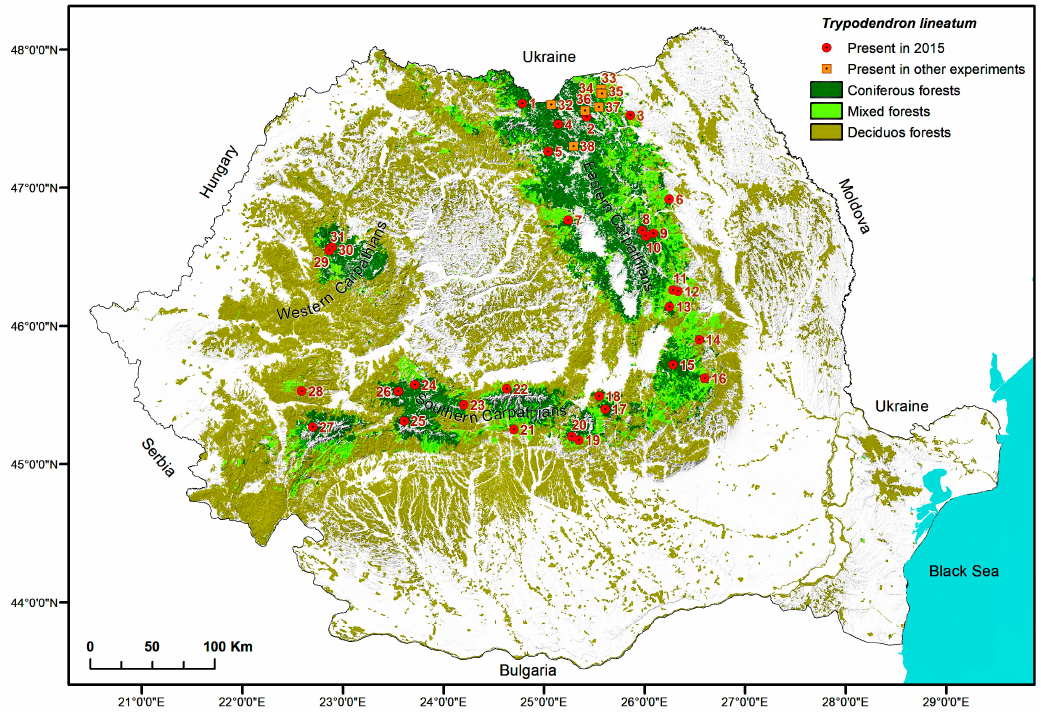
Figure 2. Sampling locations where Trypodendron lineatum was found in 2015 or on other occasions mentioned in this study.